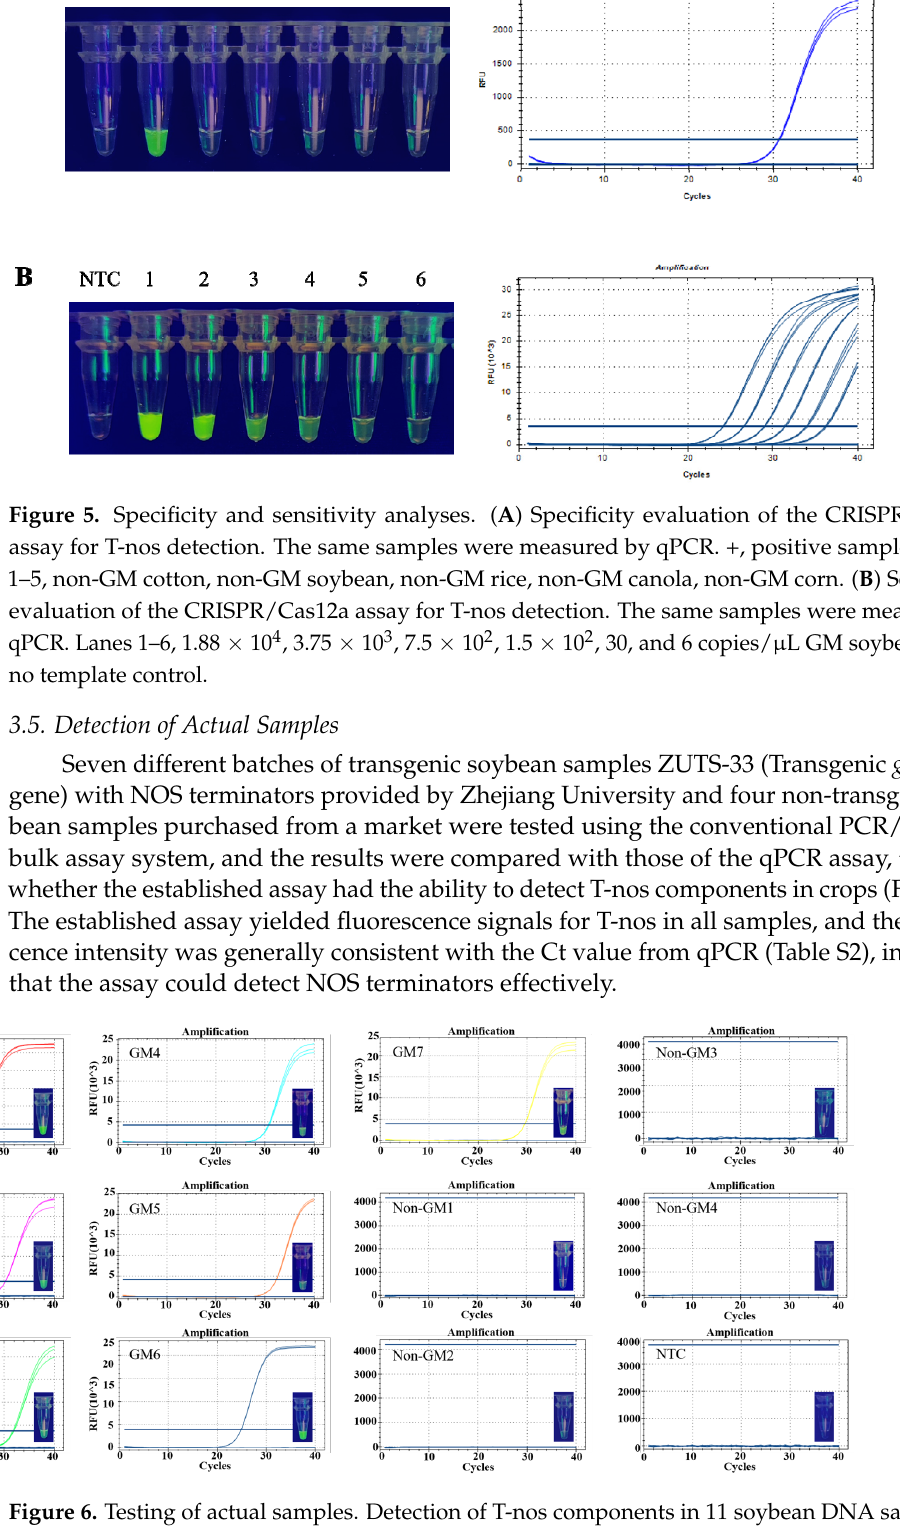
Figure 6. Testing of actual samples. Detection of T-nos components in 11 soybean DNA samples by CRISPR fluorescence detection system and qPCR.